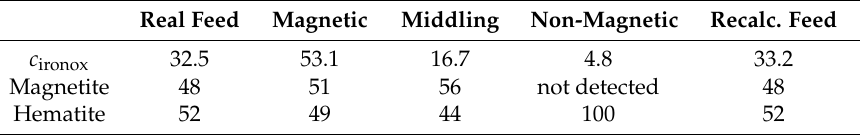
Table 4. c ironox , magnetite and hematite proportions for the real feed, recalculated feed and the products measured by X-ray diffractometry (XRD). All values for c ironox in wt%, for magnetite and hematite in